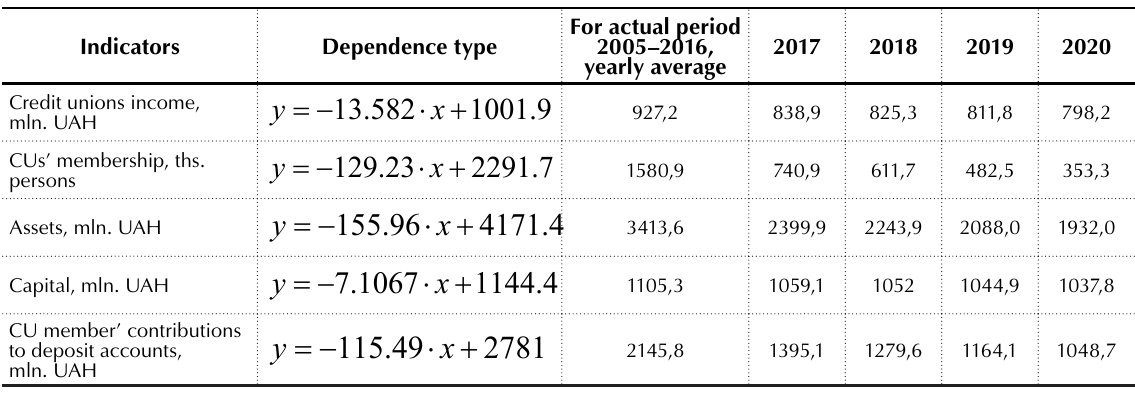
Table 2. Forecast of credit unions’ main indicators,